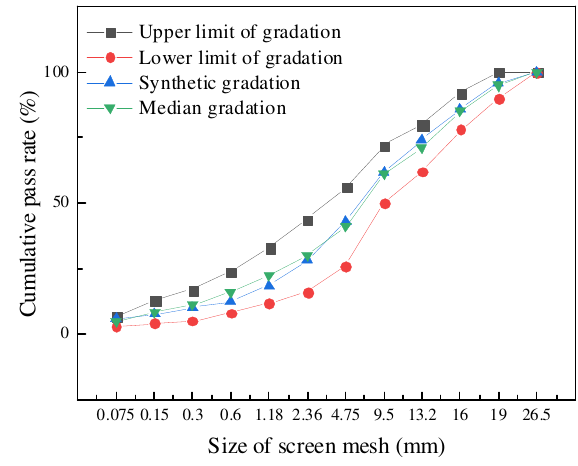
Figure 1. Mineral gradation curves.